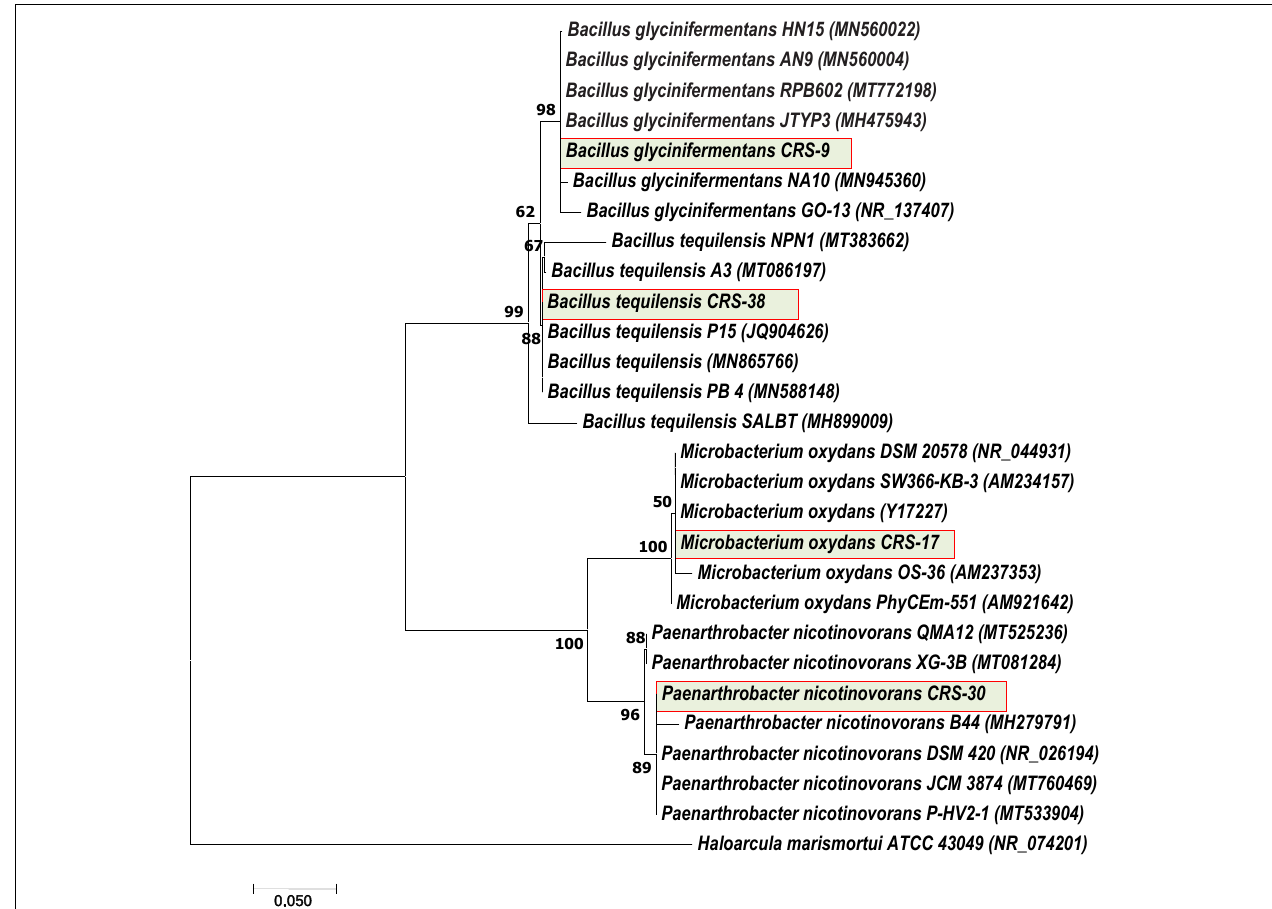
FIGURE 2 | Neighbor-joining tree derived with CLUSTAL W and MEGA 5.0 by analysis of 16S rRNA gene sequences. The numbers at nodes indicate bootstrap support values, as calculated with MEGA 5.0. Bacterial strains used in this study are presented in highlighted box.